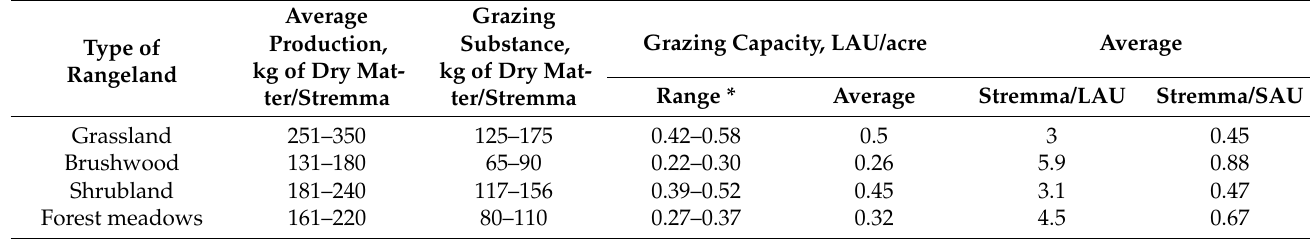
Table 3. Average production, grazing substance, and grazing capacity of rangelands.